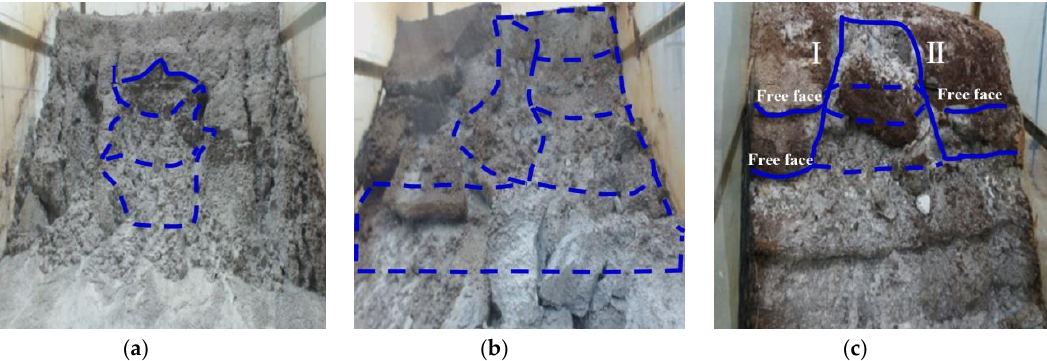
Figure 18. Slope model test monitoring system (A. Transparent observation box. B. Test slope. C. High-resolution camera. D. Rainfall device. E. Water storage and groundwater level control device. F. Rainfall measuring device. G. Valve.).